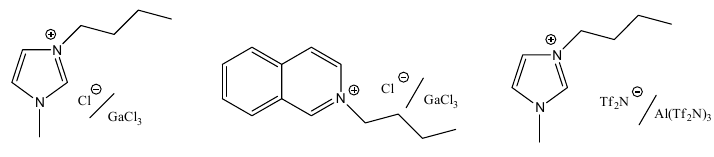
Table 1. Reactions of methyl linoleate with propene under pressure at 100 °C.